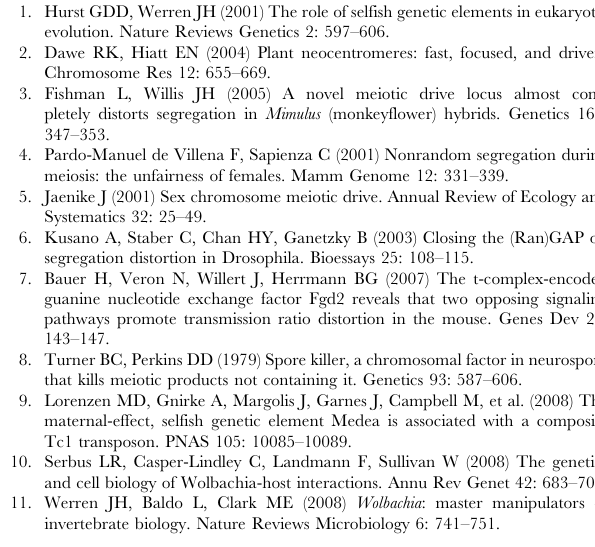
Movie S1 Arrest phenotype of peel-1 -affected embryos, focal plane 1. Time-lapse images of two peel-1 -affected embryos are shown. Embryo on the right is approximately 2 h older than the embryo on the left. Images were captured every 10 min, beginning before elongation of both embryos and ending approximately 6 h after 2-fold arrest of the younger (left-hand) embryo. (MOV) Movie S2 Arrest phenotype of peel-1 -affected embryos, focal plane 2. More proximal focal plane of the same peel-1 -affected embryos shown in Movie S1. This focal plane highlights epidermal leakage in both embryos and thinning of the tail in the left-hand embryo. (MOV) Movie S3 Wild-type embryo. Time-lapse images of a wild-type embryo. This embryo is approximately 30 min older than the left- hand embryo in Movies S1 and S2. Images were captured every 10 min, beginning approximately 4 h before the 2-fold stage and ending at hatching, which occurs approximately 6 h after the 2- fold stage.